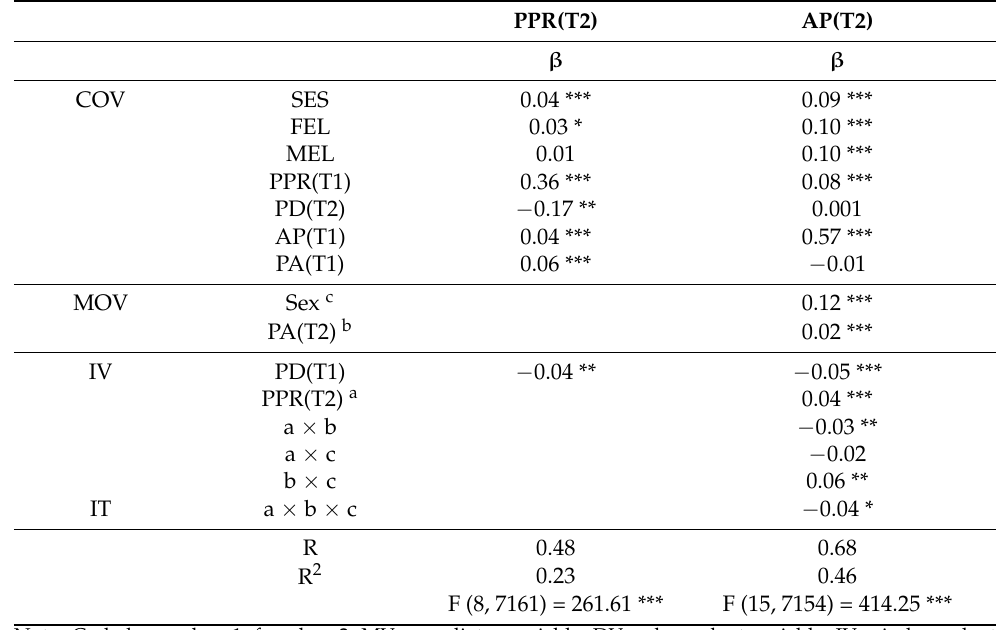
Table 2. Testing the moderated mediation effect of depression on academic